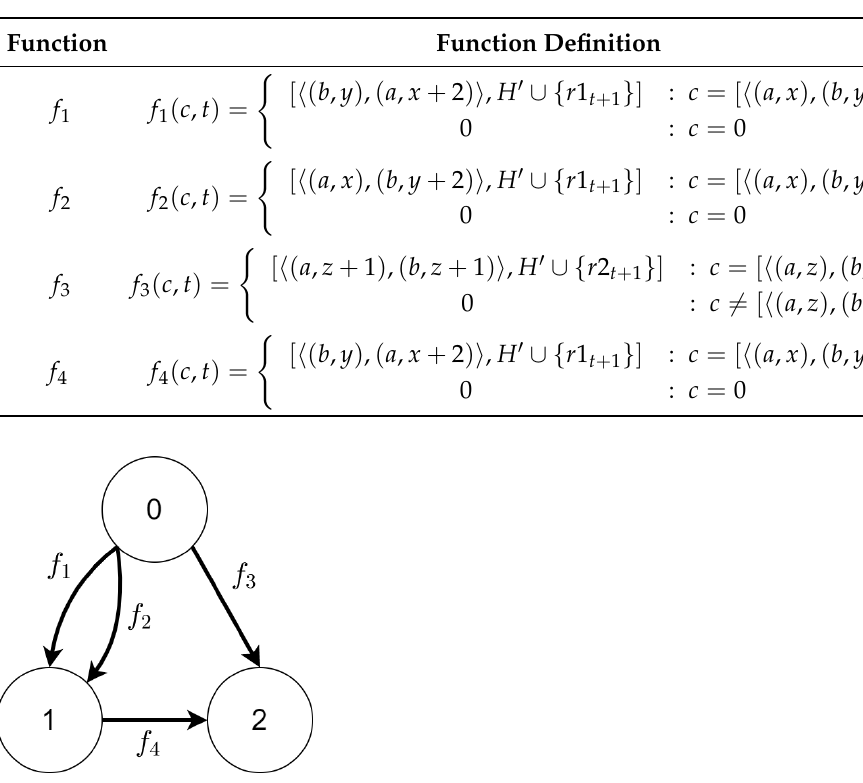
Figure 2. The state space generated from Tracking Transition System defined in Table 3. Mission progress functions definitions are defined in Table